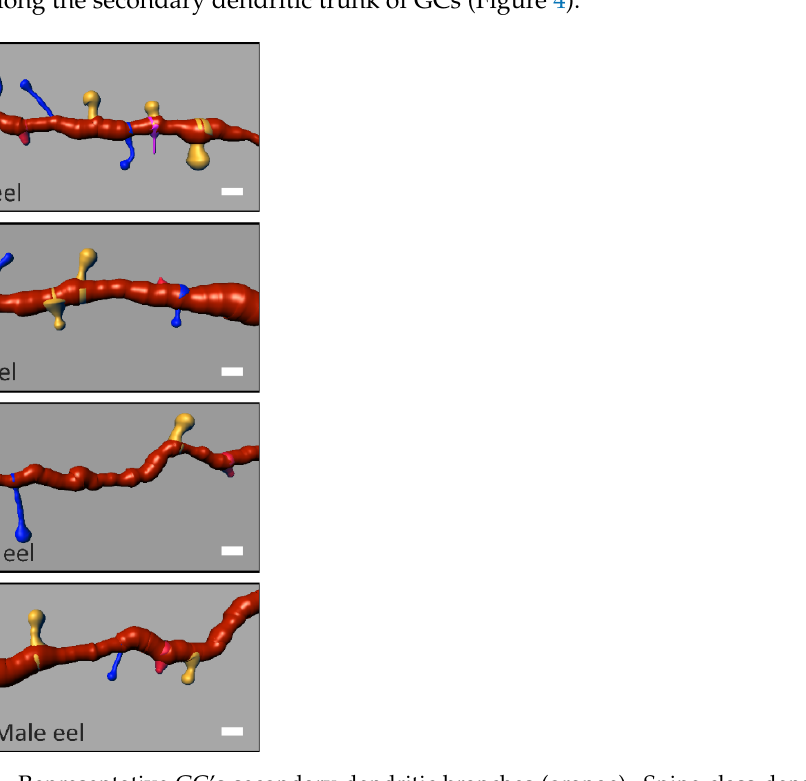
Figure 4. Representative GC’s secondary dendritic branches (orange). Spine class densities and differences among the Glass, the Elver, the Yellow and Silver male eels. (Scale Bar = 1 µm). Mushroom spine (yellow); long thin spine (blue); stubby spine (red); filopodia (magenta).